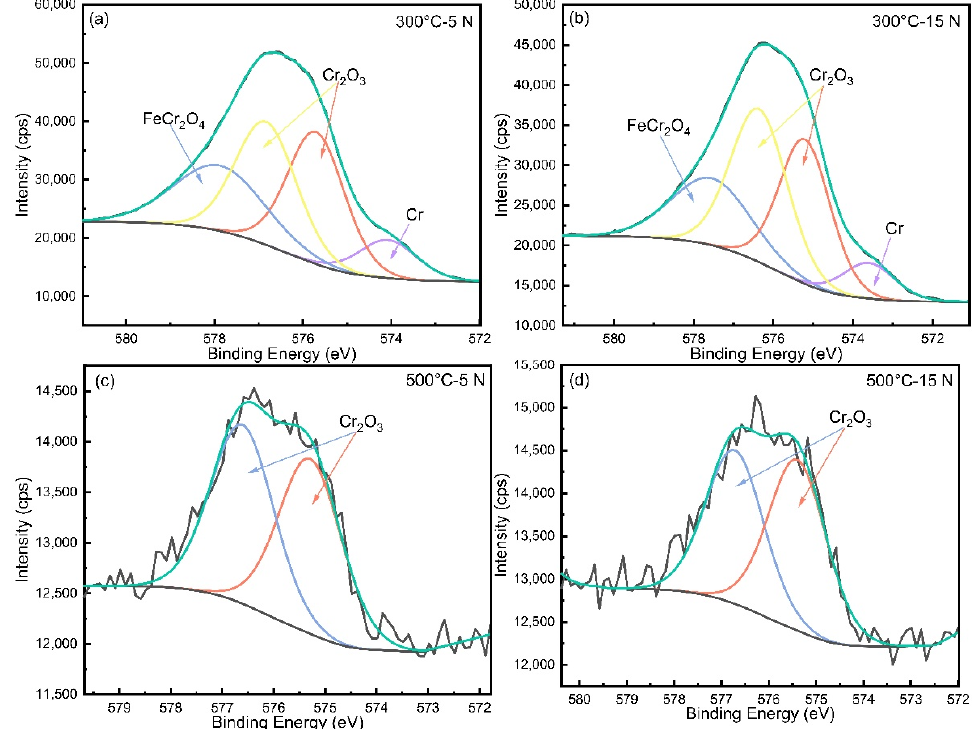
Figure 8. Spectra of Cr 2p of wear tracks under different conditions. ( a ) 300 °C–5 N, ( b ) 300 °C–15 N, ( c ) 500 °C–5 N, and ( d ) 500 °C–15 N.